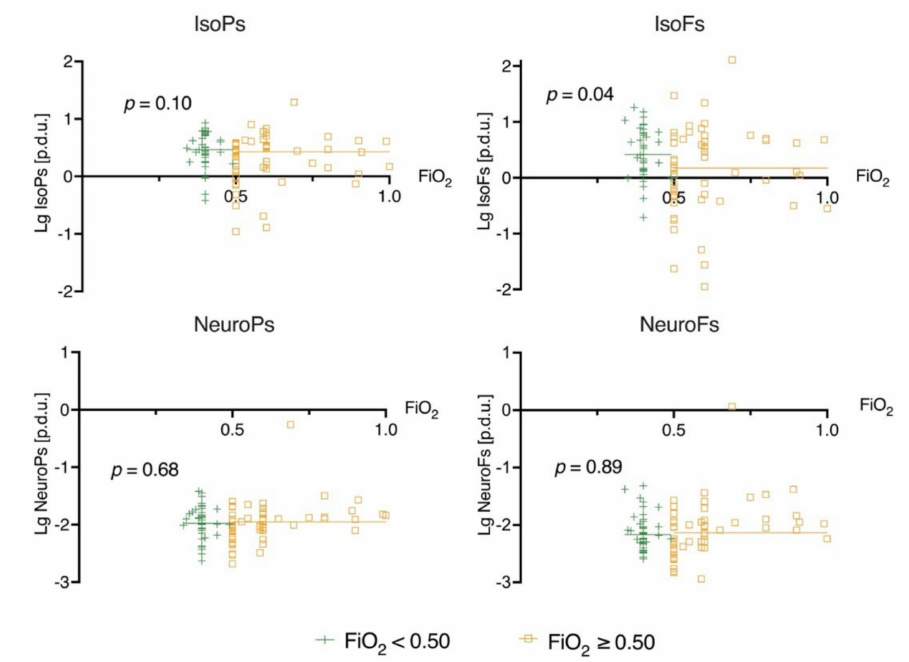
Figure 2. Scatterplot of biomarker and FiO 2 levels on ICU admission (0 h). The patients are divided into two groups by the median FiO 2 value on intensive care unit admission. The straight lines seen in the plots represent the median values of the biomarkers concerned. The p -value indicates the significance of the Mann–Whitney U test between the biomarker level on admission in the patients’ FiO 2 below vs. above the median (0.50). Definitions of abbreviations: [p.d.u.] = procedure defined unit; Lg = base 10